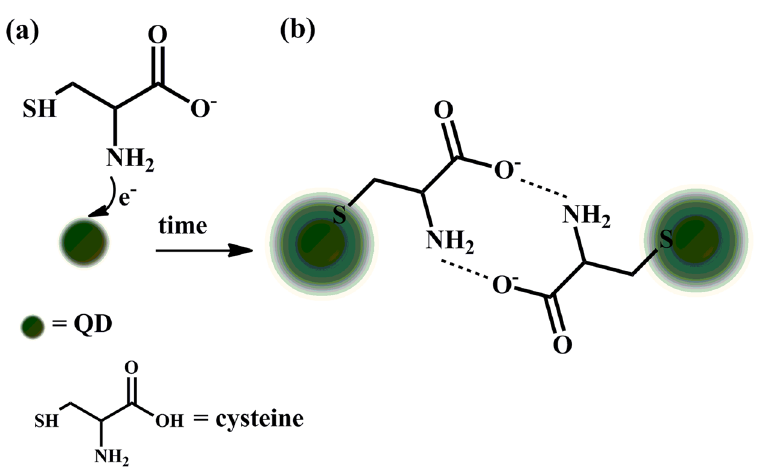
Figure 3. ( a ) Photoinduced electron transfer (PET)-mediated quenching of QD. ( b ) Fluorescence recovery of QDs by PET